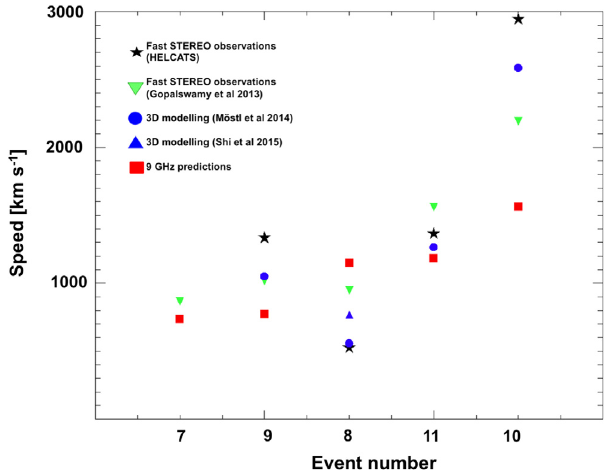
Fig. 5. Observed and predicted CME speeds. The black stars represent the higher of the two CME speeds derived from a geometric fit of observations from each of the two STEREO spacecraft (HELCATS catalogue). The green inverted triangles show the higher of the two CME speeds measured in the STEREO/ COR2 images by Gopalswamy et al. (2013). The blue circles and blue triangles are the speeds resulting from multi-spacecraft modelling by Möstl et al. (2014) and Shi et al. (2015). The red filled squares denote the speeds found from the microwave fluence by using least squares (LS)